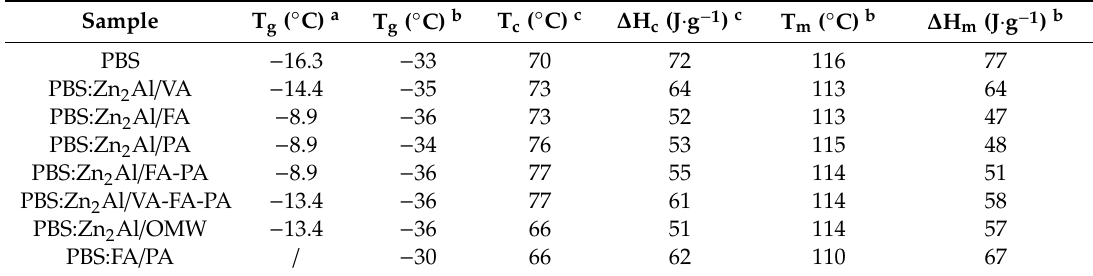
Table 2. Thermomechanical results of PBS, PBS:FA / PA, and PBS:Zn 2 Al / X.